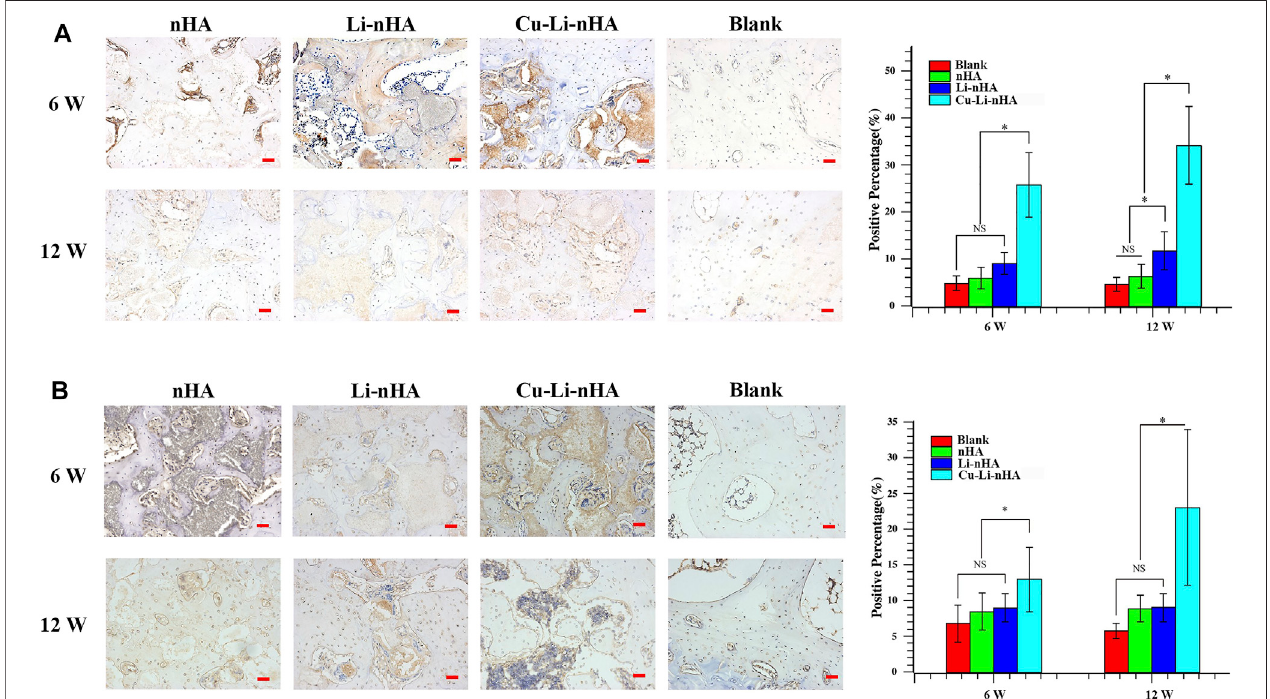
FIGURE10| ImmunohistochemistryandpositiveratioanalysisofVEGF (A) ,SDF-1 (B) .BlankGroup:withoutONFHmodelingandscaffold-implantationoperation. Scale bar in the bottom right-hand corner of each image (red): 100 μ m. Statistical analysis was conducted using a one-way analysis of variance with post-hoc Bonferroni ’ s multiple comparisons test. NS: p > 0.05, * p < 0.05.